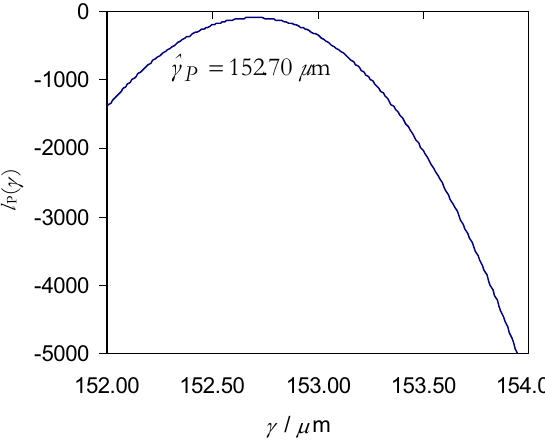
(cid:11) (cid:12) (cid:419) P (cid:34) is plotted against the parameter of